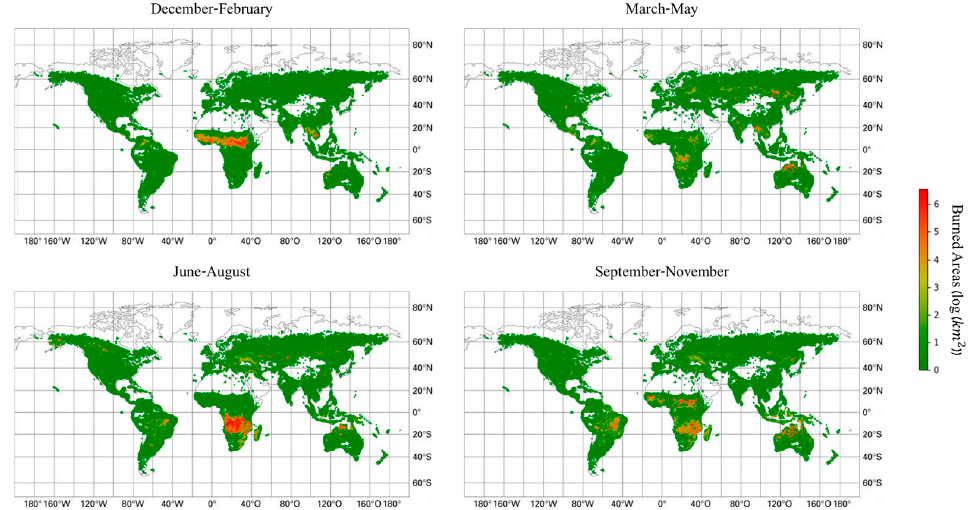
Figure 2. Descriptive statistics of burned areas—logarithmic scale. The figure presents descriptive statistics of the total burned areas in each season. We added the value 1 to each pixel before applying a logarithmic transformation.